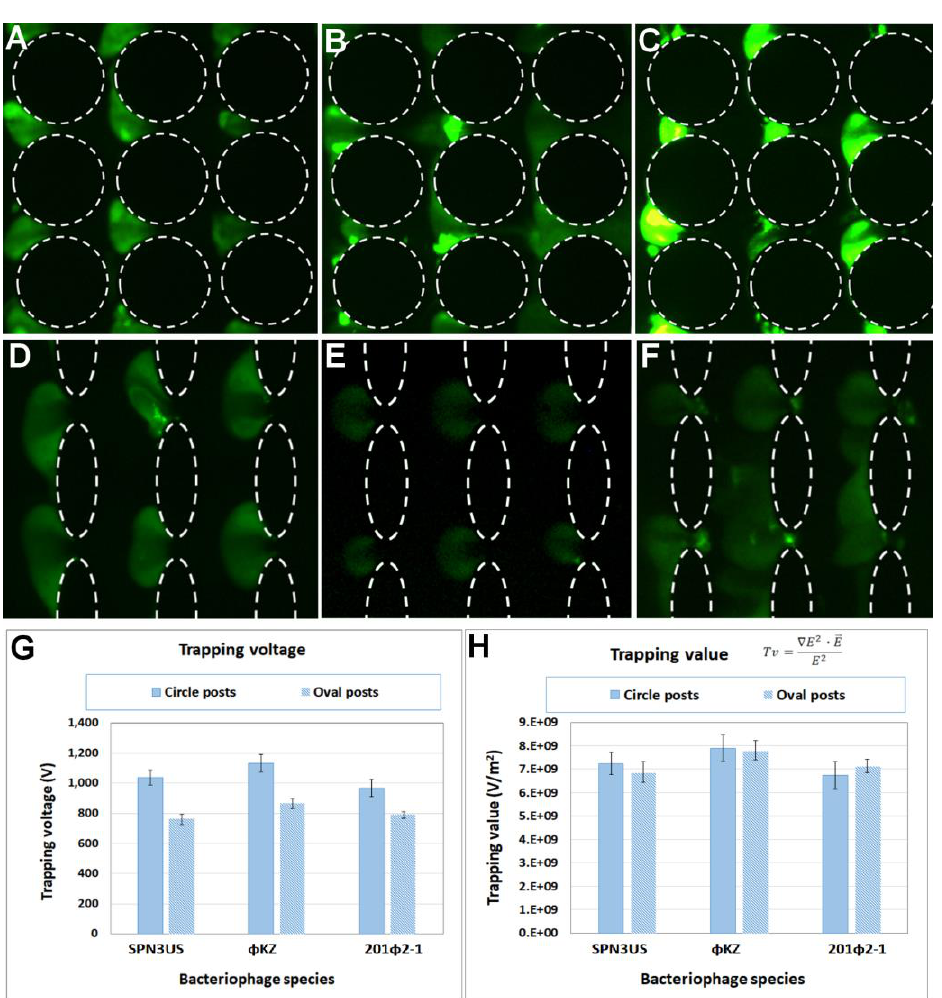
Figure 3. Results of the dielectrophoretic trapping of all three phages. Circle-shaped posts: ( A ) SPN3US at 1200 V, ( B ) φ KZ at 1100 V and ( C ) 201 φ 2-1 at 1100 V. Oval-shaped posts: ( D ) SPN3US at 800 V, ( E ) φ KZ at 750 V and ( F ) 201 φ 2-1 at 750 V. ( G ) Experimental characterization of the trapping voltage, and ( H ) Estimation of the trapping value ( Tv ) in both iDEP channel designs for the three types of bacteriophages in this study. Table S1 in the Supplementary Material includes a summary of the trapping voltage and Tv estimations.